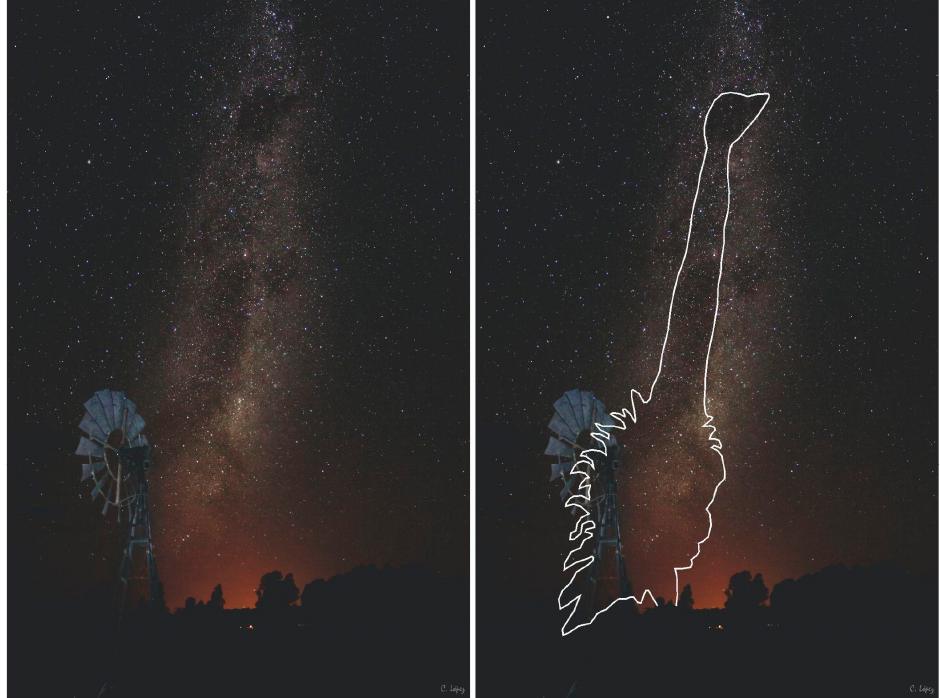
Figure 7. The celestial rhea and Milky Way according to references from Moqoit of the Gran Chaco region (Photograph taken by Cristian López, Astrophotographer. Drawing by Anxo Rodríquez-Paz. INCIPIT-CSIC).